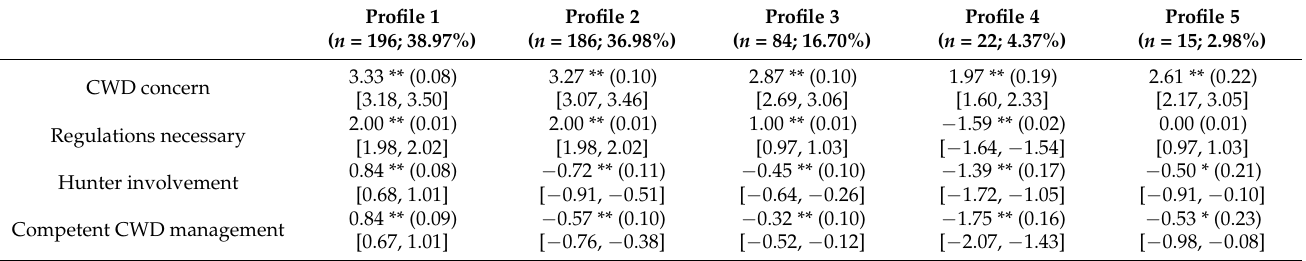
Table 3. Results of the latent profile analysis of Texas hunters. For each profile, this table reports the coefficient (standard error) [95% confidence interval] for each variable used in the latent profile